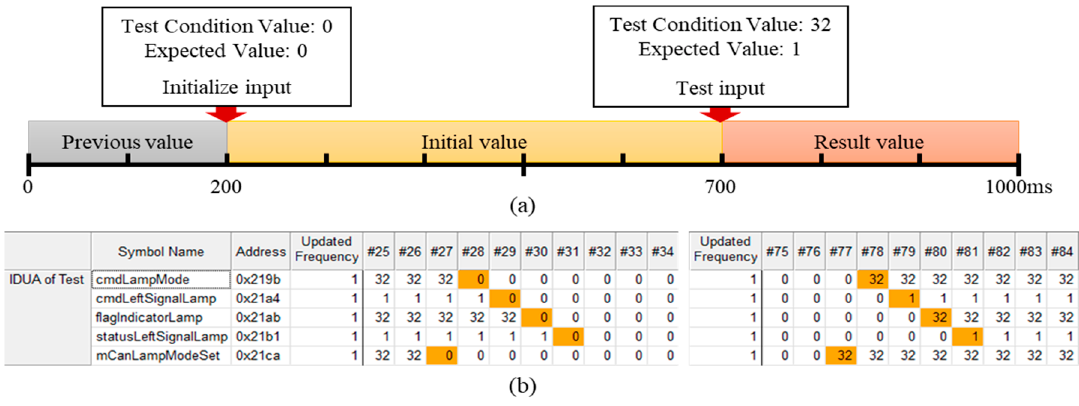
Figure 10. Unit Test of “Left Turn Signal”: ( a ) “Left Turn Signal” Unit Test Specification; ( b ) Initialize and Test input (MUI IDUA,IDUR ).